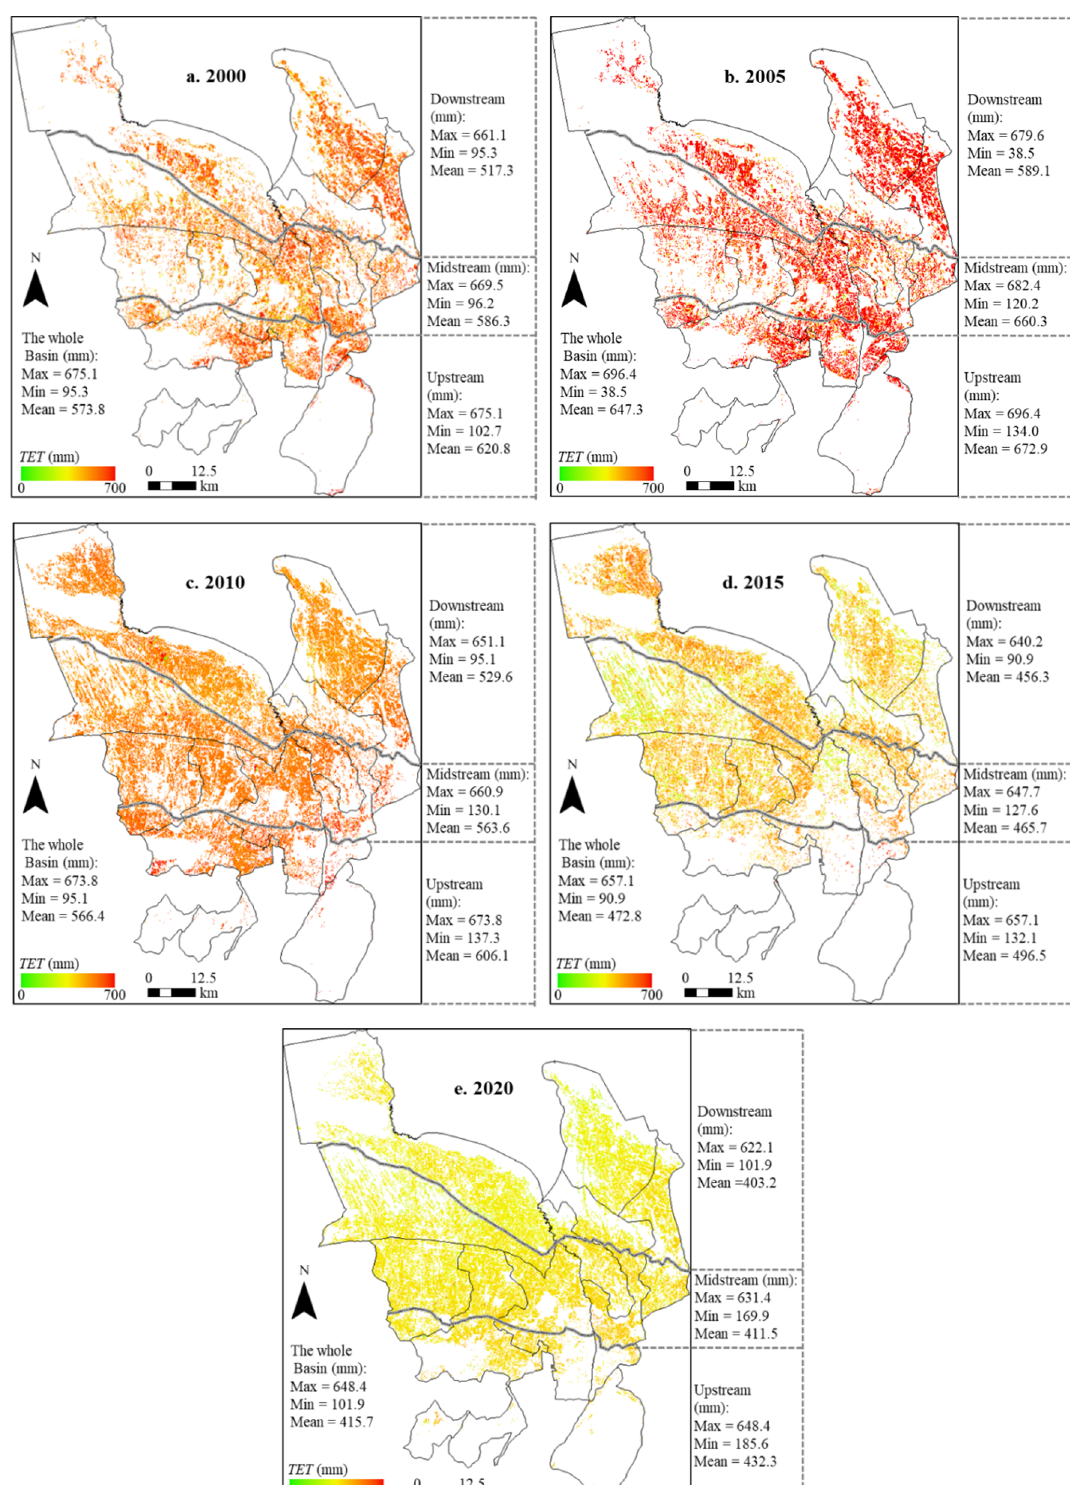
Figure 8. Spatial distributions of the fused total evapotranspiration ( TET , mm) during the growing seasons of ( a ) 2000, ( b ) 2005, ( c ) 2010, ( d ) 2015, and ( e ) 2020 in cotton fields under film-mulched drip irrigation in the Manas River Basin.